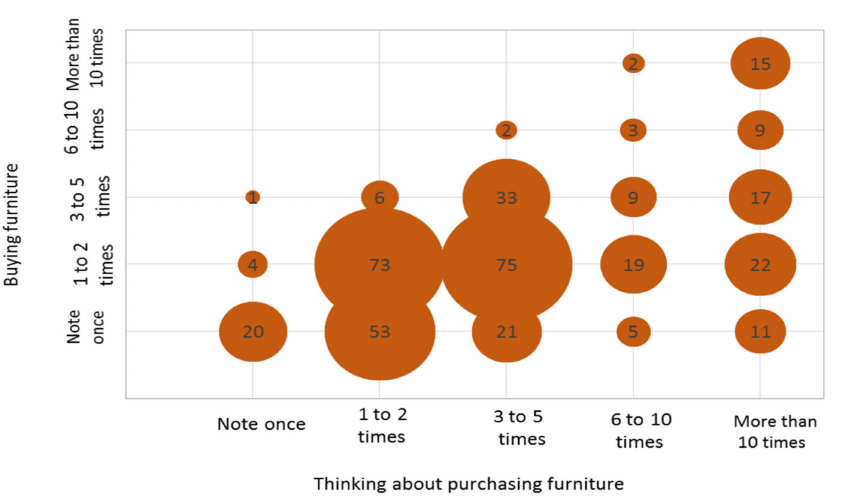
Figure 6. Correlation between the frequencies of thinking about and buying furniture ( N = 400). Spearman’s rank-order coefficient confirmed a significant low, positive correlation (r S (400) = 0.128, p = 0.010) between the importance of gathering information and the frequency of buying furniture (Figure 7). The conducted results can be supported by the findings of Liang [66] that the higher the level of consumers’ product knowledge, the higher the tendency of impulse purchasing behavior.